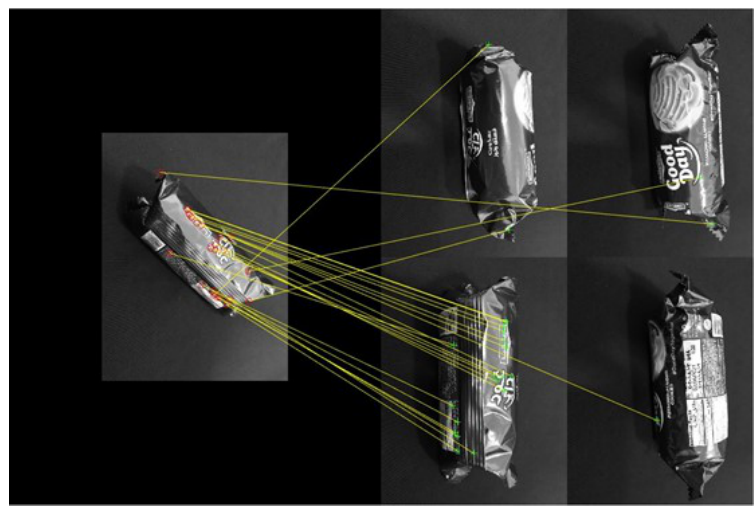
Figure 17. The feature matching process of similar items.